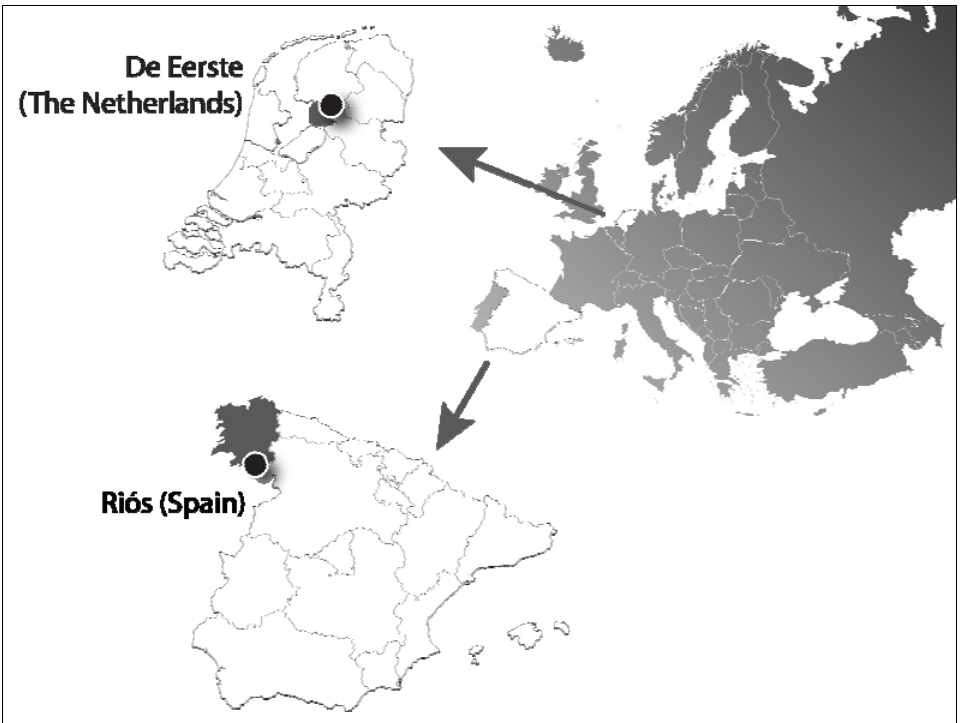
Figure 1. Map Indicating Locations of Case Study Farms in the Netherlands and